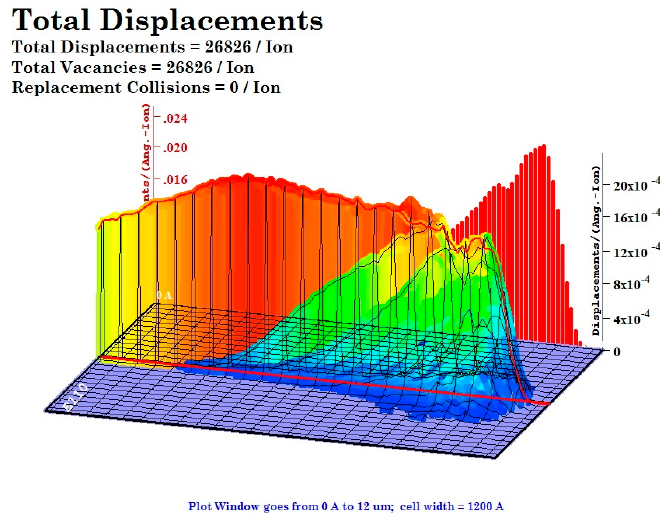
Figure 10. Damage caused by 120 MeV Mo in E110 alloy.